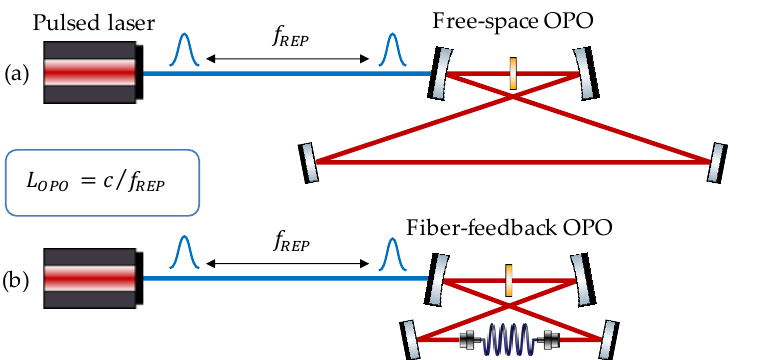
Figure 1. Schematic of a synchronously-pumped OPO. ( a ) A conventional free-space OPO cavity. ( b ) A fiber-feedback OPO using intracavity fiber to reduce the free-space path